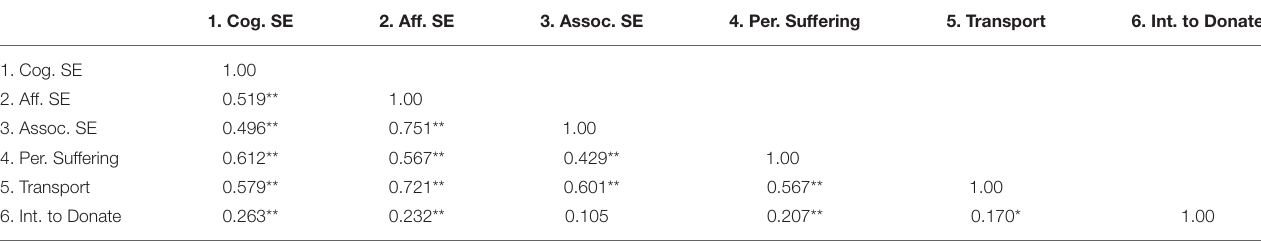
TABLE 2 | Correlations.